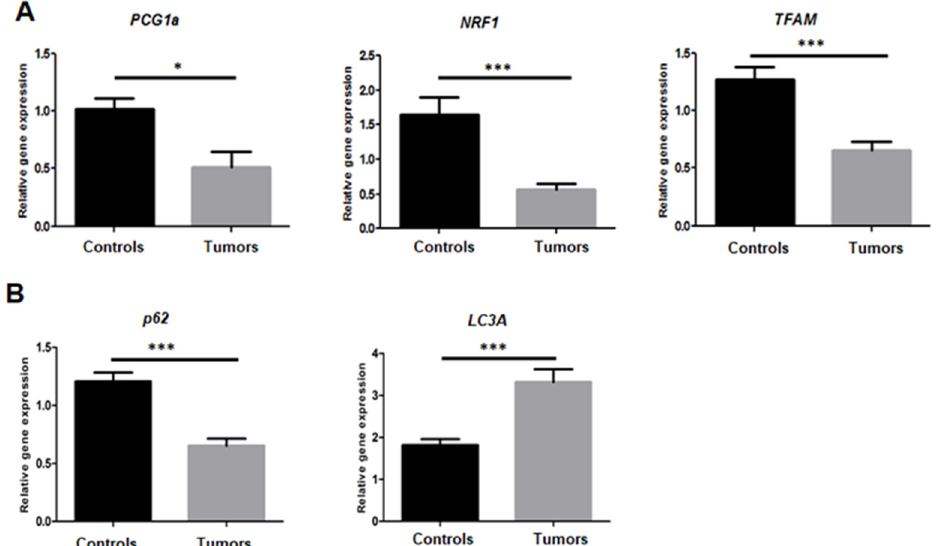
Figure 5. Mitochondrial biogenesis and mitophagy analysis. ( A ) Relative expression of mitochondrial biogenesis markers: PCG1 α , NRF1, and TFAM genes with significant difference between tumors and controls ( p -values calculated by t -test; * <0.05 and *** <0.0001). ( B ) Relative expression of mitochondrial mitophagy markers: P62 and LC3a, with significant difference between tumors and controls ( p -values calculated by t -test; *** <0.0001).